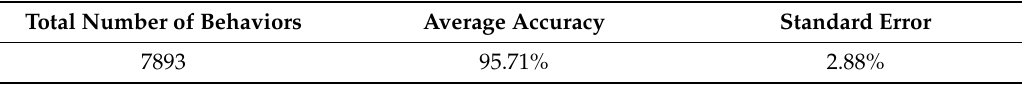
Table 2. Average accuracy and standard error.